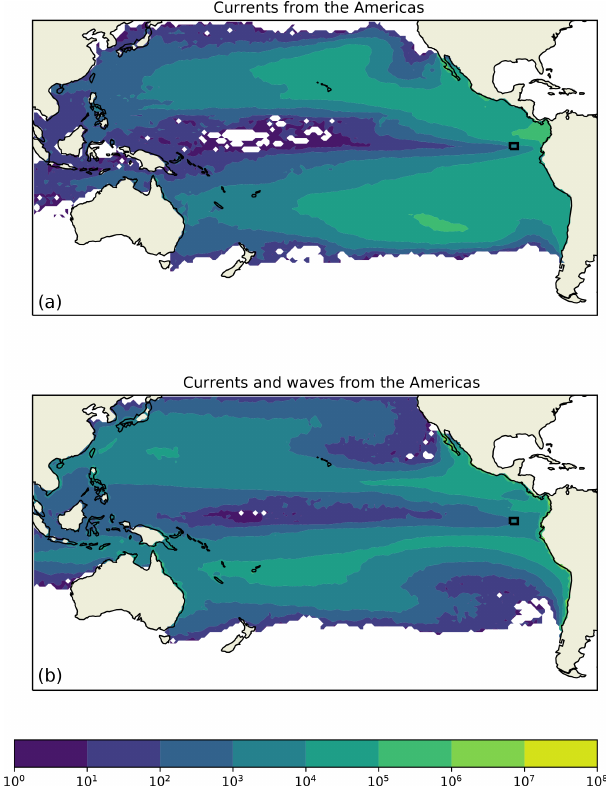
Figure 4. Map of the “Fate from the South American coastline” scenario, showing the density of particle trajectories that start on the western coast of the Americas on a logarithmic colour scale for particles carried by currents only (a) and for particles carried by the currents and waves (b) . Maximum length of the trajectories is 5 years. Most particles end up in one of the subtropical gyres, and the Galápagos (black square) is at a relative minimum in both